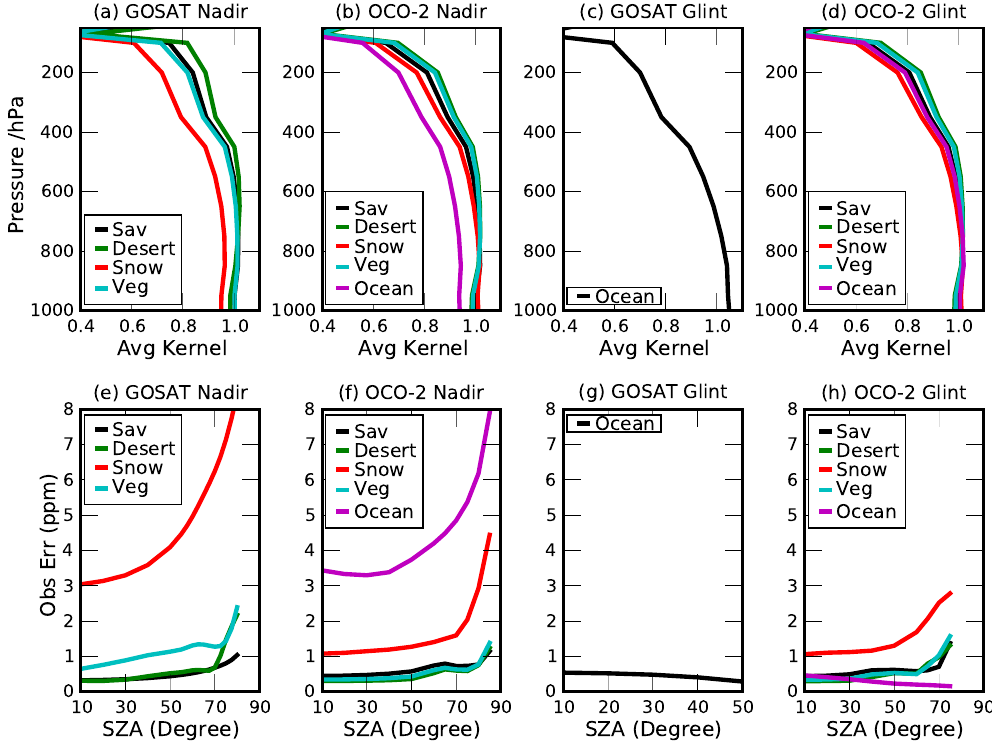
Fig. 2. Averaging kernels (dimensionless, top panels) and single measurement error (ppmv, bottom panels) for nadir and sun-glint viewing modes of the Greenhouse gases Observing SATellite (GOSAT) and the Orbiting Carbon Observatory (OCO-2) instruments. The averaging kernels are for different land types at a solar zenith angle (SZA) of 10 ◦ and an aerosol optical depth (AOD) of 0.1. Observation errors are shown as a function of SZA for different land types and an AOD of 0.1.